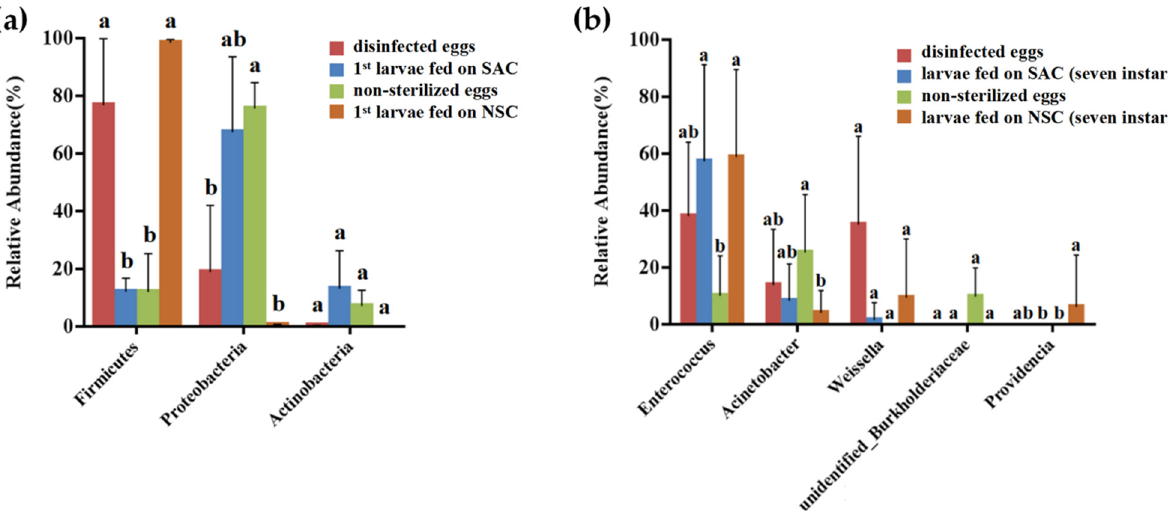
Figure 4. Bar chart of the phylum- and genus-level microbiota classifications for different diets (>5%): ( a ) variations in core bacterial phyla in/on the L. xylina ’s eggs and of larvae in the first instar fed on different diets; ( b ) variations in bacterial communities in/on the L. xylina ’s eggs and across seven instars for larvae fed on different diets at the genus level. The bars marked with different letters for the same bacterial phylum are significantly different in their abundance based on statistical analysis ( p < 0.05).